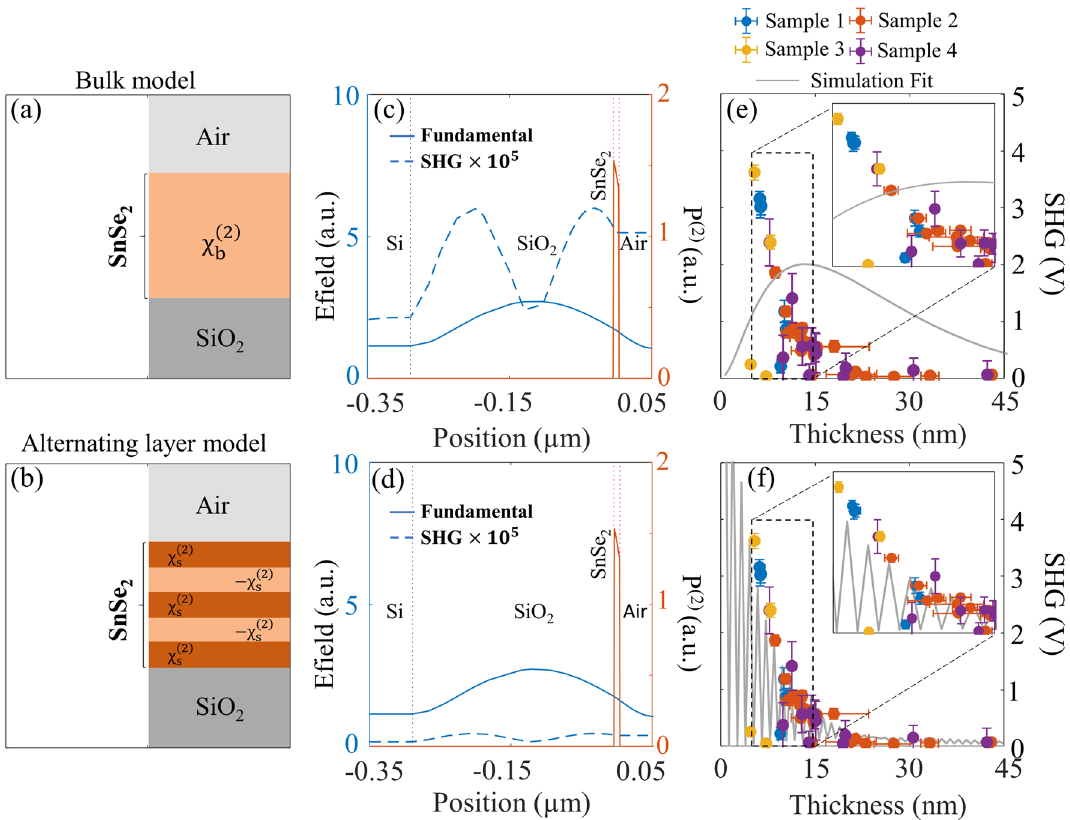
Figure 4. Comparison of thickness-dependent SHG experiments with nonlinear wave propagation simulations for multilayer SnSe 2 . Schematic cross-section view of the: ( a ) bulk nonlinearity model, and ( b ) alternating nonlinear layer model. ( c , d ) Simulation results showing the fundamental field profiles (solid blue curves), SHG field profiles (dashed blue curves) and nonlinear polarization (solid red curves). ( e , f ) Comparison of the experimental (solid colored circles) and simulated (solid blue curves) SHG signals for the two different nonlinearity models considered here. A zoomed-in view of this plot is shown as an inset. (Created in MATLAB v9.6, R2019a, https:// in. mathw orks.